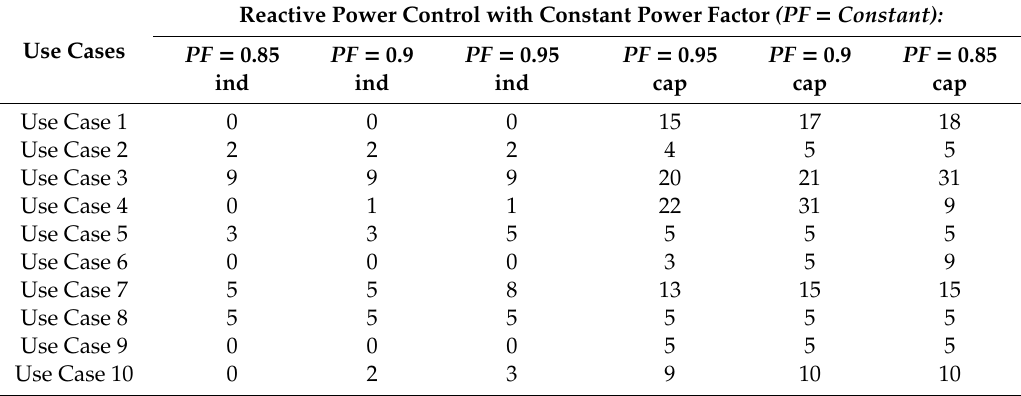
Table A6. Reactive power control with constant power factor: Voltage deviations.